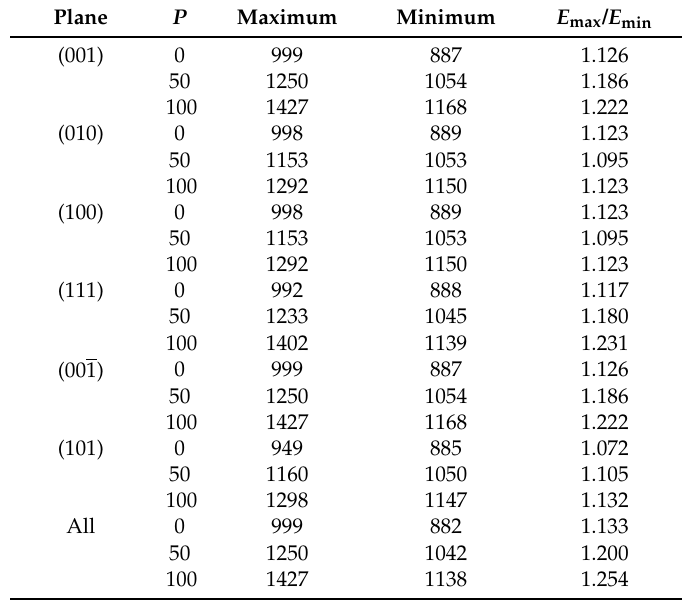
Table 4. The maximum and minimum values of Young’s modulus (in GPa) in different planes and for pressures for I4